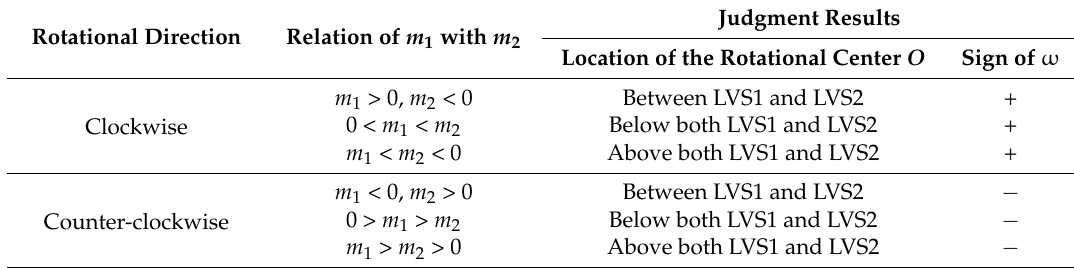
Table 1. The relations of ω with rotational direction, center location, m 1 and m 2